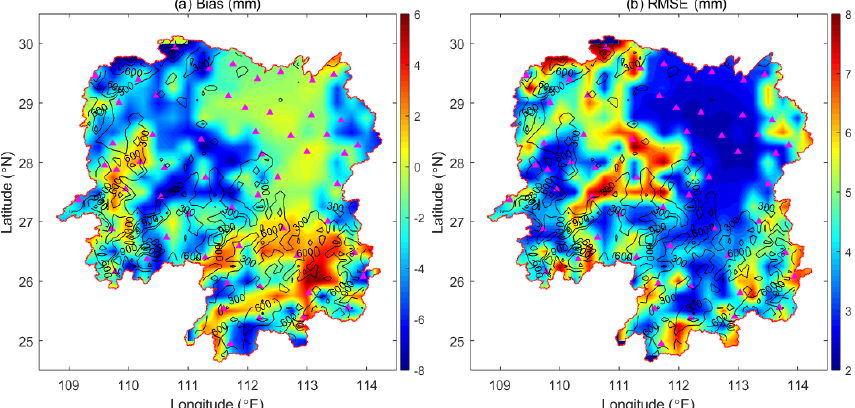
Figure 6. Map of (a) bias and (b) RMSE of the differences between ERA-I PWV and GNSS-interpolated PWV over the Hunan Province for the year 2015. Black contours represent the elevation (unit: m).